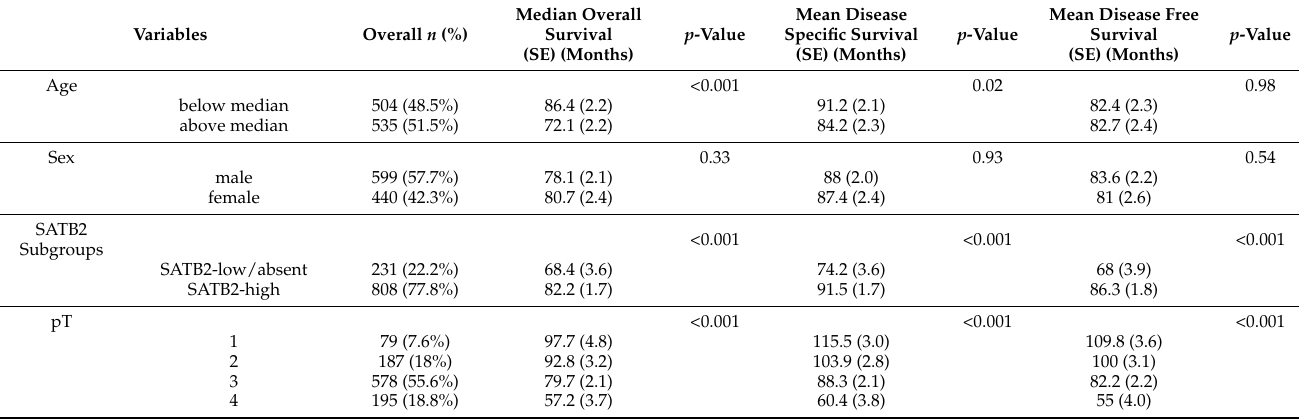
Table 1. Distribution and prognostic impact of SATB2-expression and clinicopathological parameters in the overall cohort.